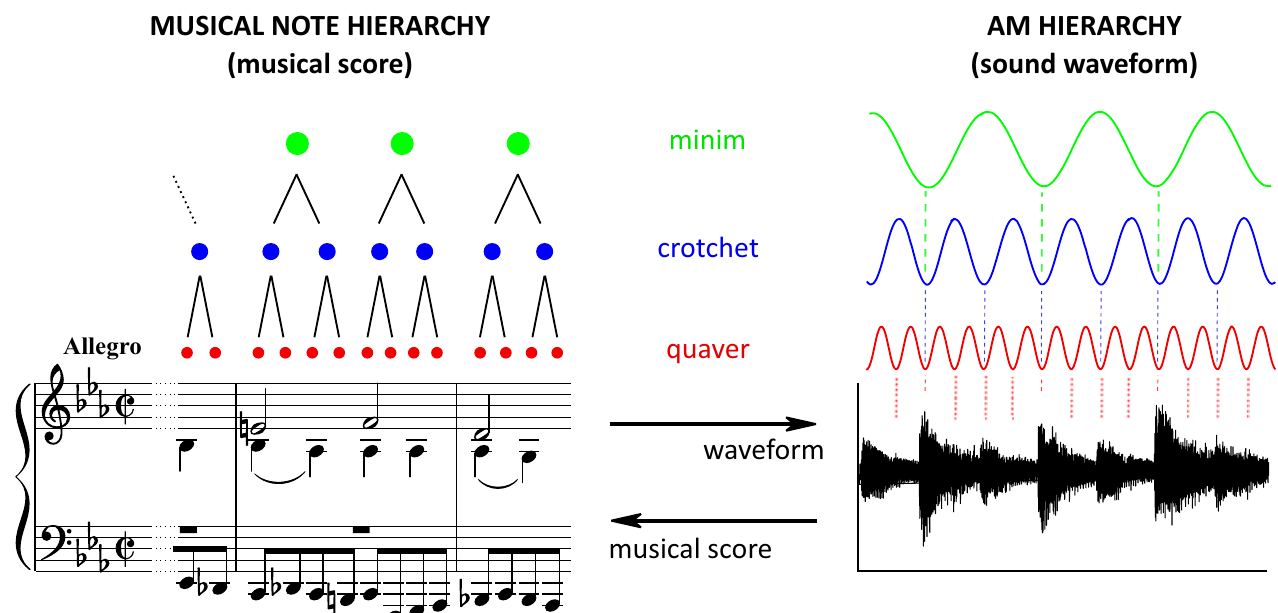
Fig 5. Schematic depiction of the hierarchical AM structure yielding Rhythm in music. Left and right are the representation by musical score and the corresponding sound waveform of a part of the 33 Variations on a waltz by Anton Diabelli, Op. 120 (commonly known as the Diabelli Variations) by Ludwig van Beethoven. In principle, musical rhythm could be hierarchically organized based on note values (left) matched to nested amplitude modulations (AM, right) in bandings spanning different temporal rates (for example, green ~2 Hz, blue ~4 Hz, red ~8 Hz, matching Table d in S4 Appendix). In the framework of Temporal Sampling theory, the AM bands (right) equate temporally to neural oscillatory rhythms. Auditory rhythm perception relies in part on neural tracking of the AM patterns at different timescales simultaneously (e.g., neural tracking of the green, blue, and red AMs in Fig 5 by neurophysiological delta, theta and alpha bands). This neural tracking is triggered by acoustic components of the sound signal such as the amplitude rise times (musical attack times) of the nested AM components which phase-reset oscillatory cortical activity. There are of course a large range of tempi used in music, for example slow ballads and fast dance songs. However, as shown by the black lines in the musical note hierarchy (left) and the dotted vertical lines in the AM hierarchy (right), the adjacent tiers of the hierarchy (i.e., green & blue and blue & red AM pairs) are dependent on each other compared with non-adjacent hierarchical relations (i.e., green- red AM pairing) and thus the hierarchy itself will expand or contract to fit the